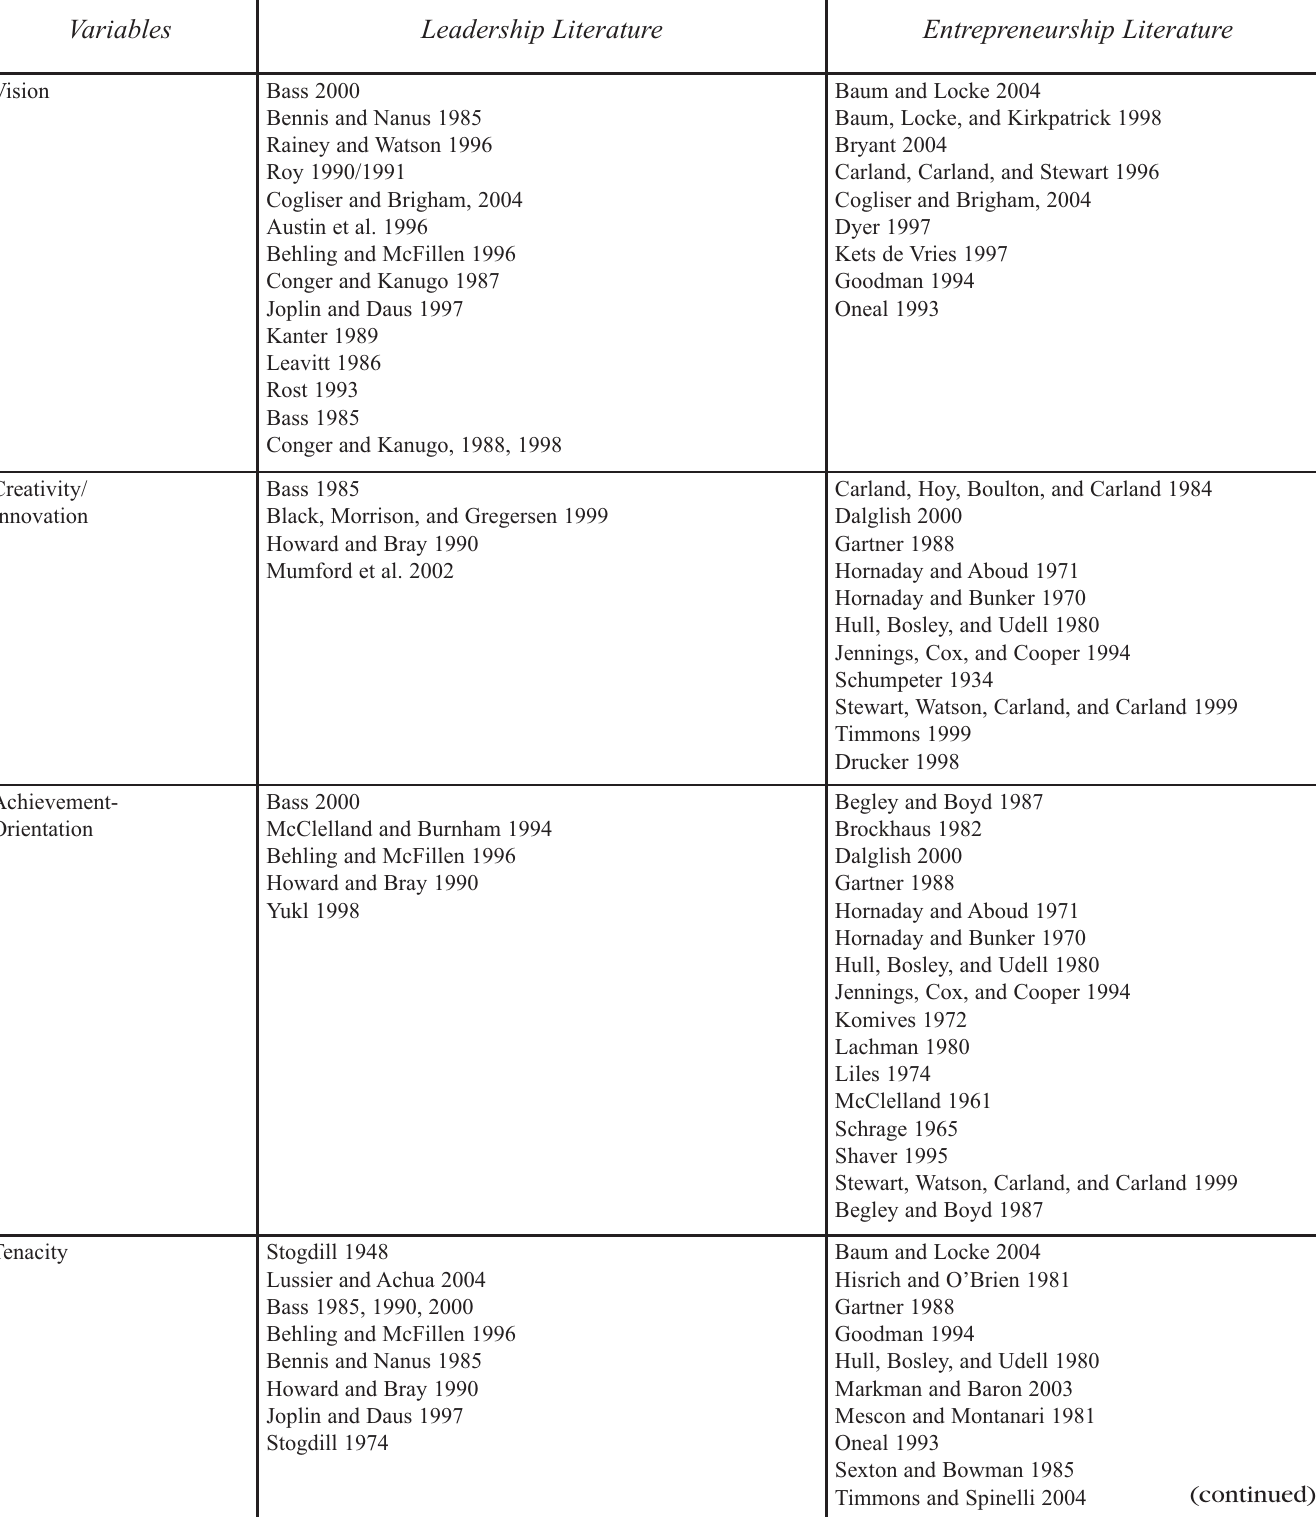
Table 1. Constructs and Research by Disciplinary Area—Review of Empirical Literature